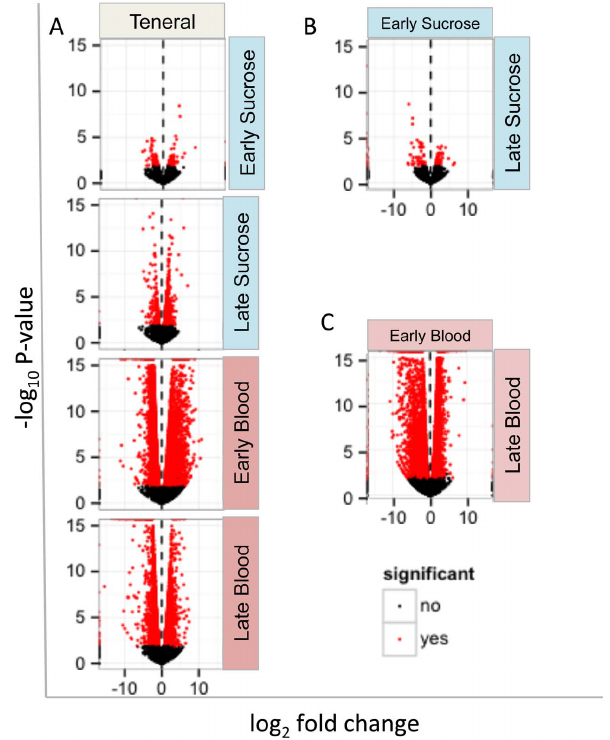
Figure 4. Volcano plots of pairwise comparisons illustrating diet effects on differential gene expression in C.sonorensis . The volcano plot is composed of comparisons of replicate normalized transcriptional states between feeding conditions including teneral, early (2, 6, 12 h pooled) or late (36 h) blood or sucrose feeding. Log2 fold change for each unigene (dots) is shown; red dots indicate statistical significance (P # 0.01) of the pairwise comparison of net transcript abundance (up or down to right or left of midline, respectively).